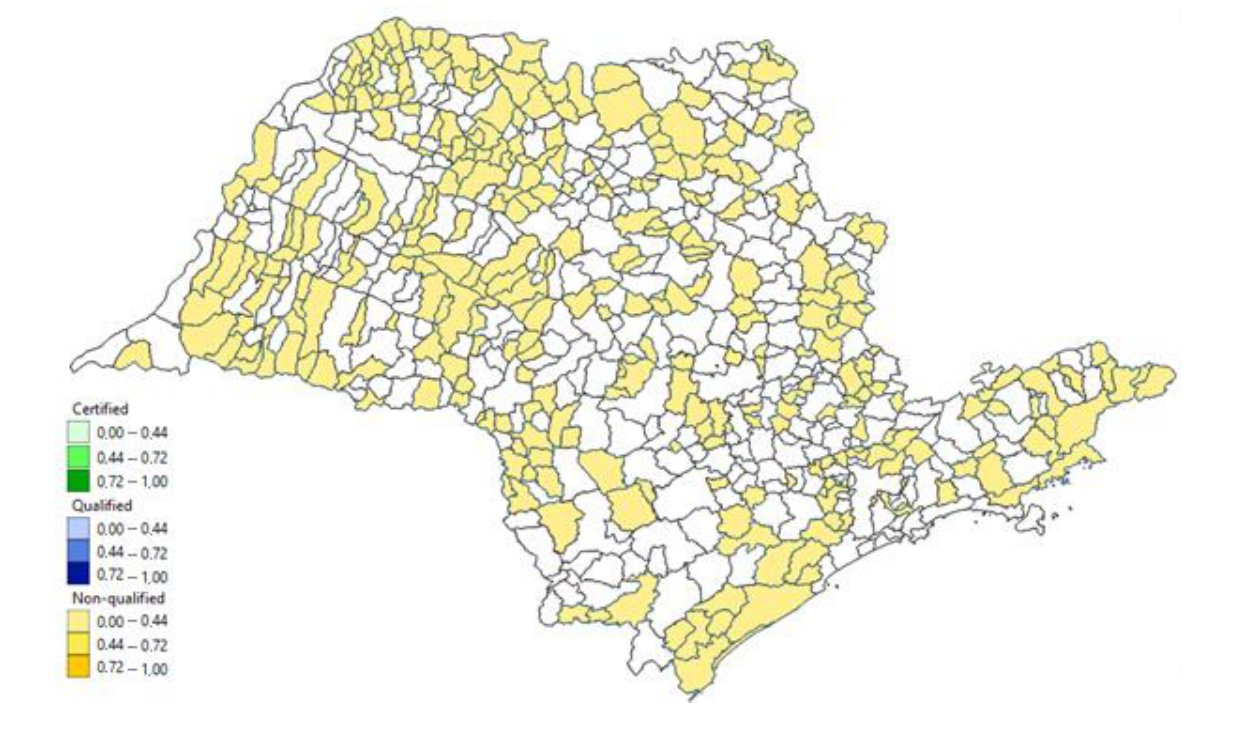
Infrastructures 2022 , 7 , x FOR PEER REVIEW Figure 4. Municipalities in the lower part of the stratification. Figure 4. Municipalities in the lower part of the stratification.